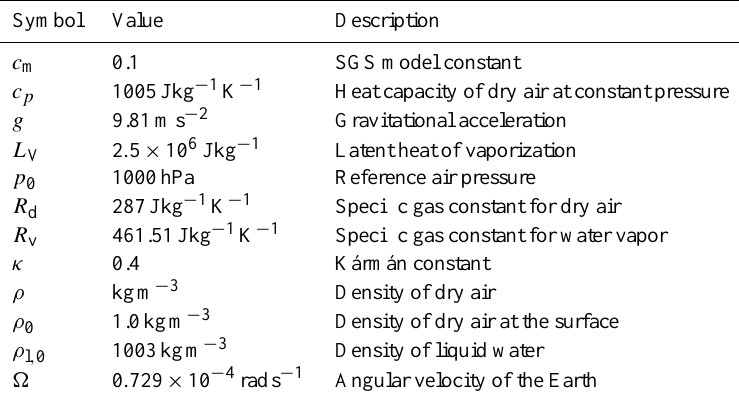
Table 1. List of general model parameters.